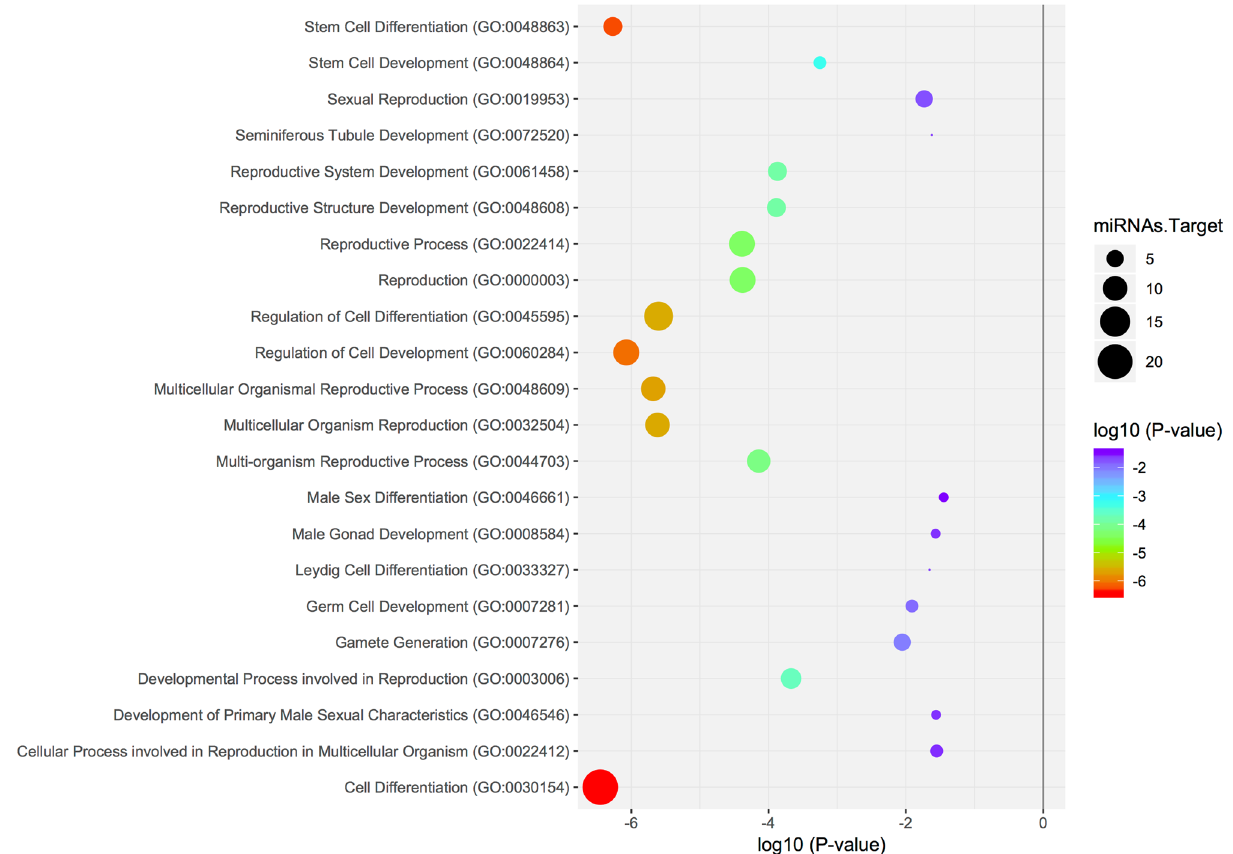
in log10 values and the size of the circle the number of target genes